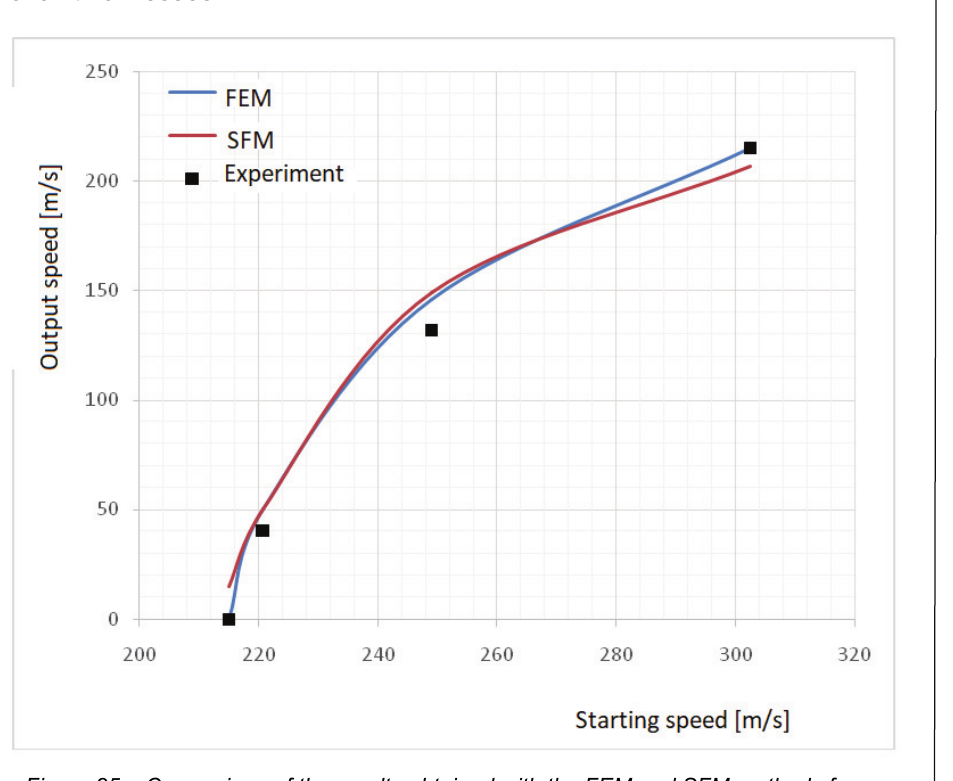
Figure 25 – Comparison of the results obtained with the FEM and SFM methods for an aluminum plate with a thickness of 15 mm, conical